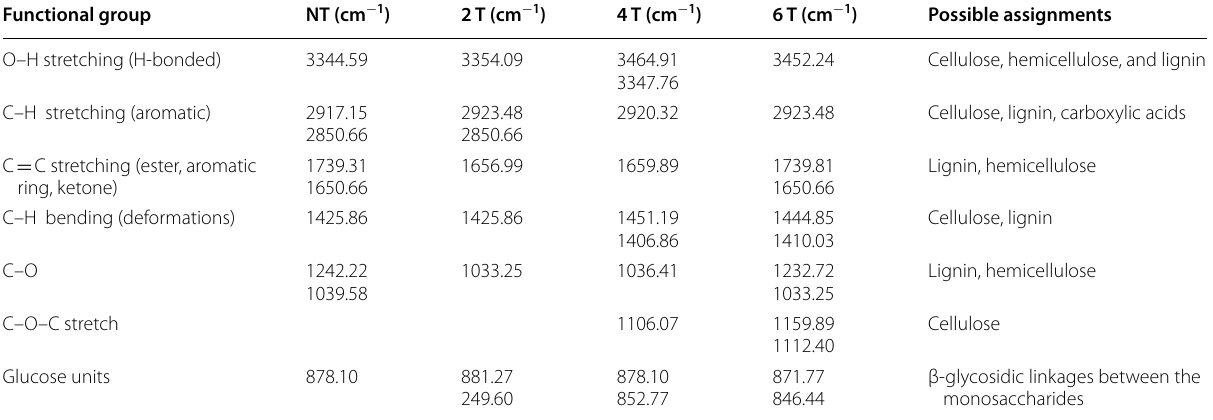
Table 2 IR spectral analysis of treated and untreated plantain fibre (Alavudeen et al. 2015) Functional group